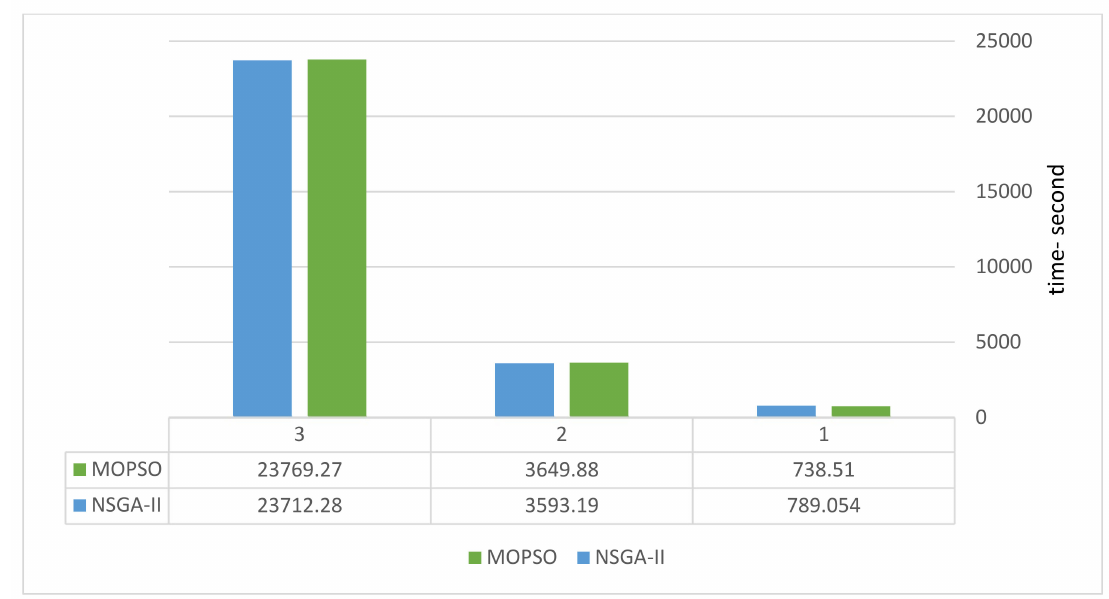
Figure 3. Comparison between the average execution time of NSGA-II and